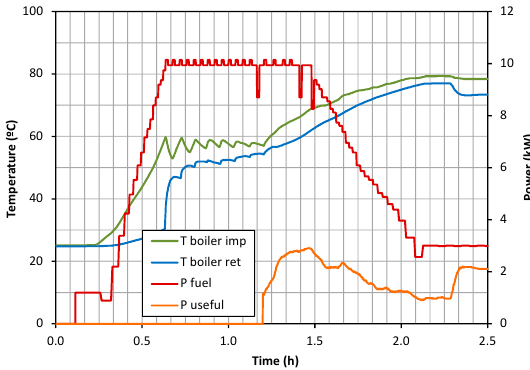
Figure 11. Temperature and power during the combustion test of LAB2.